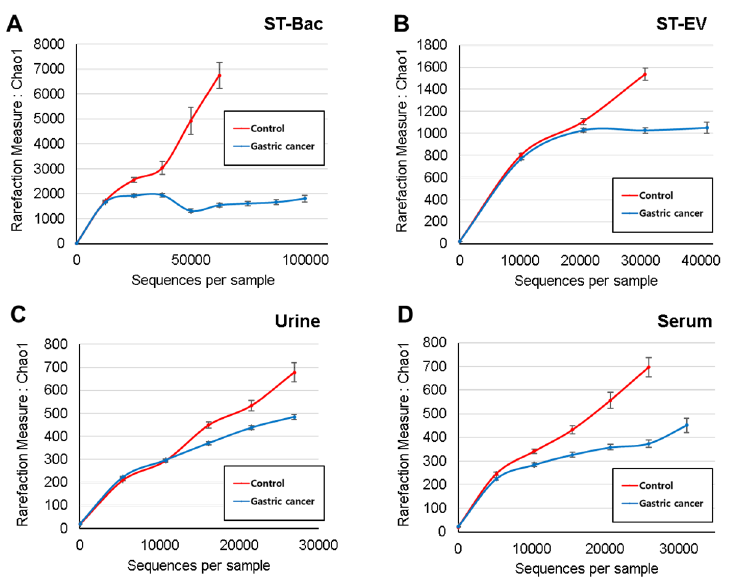
Figure 1. Comparison of alpha diversity between healthy controls and gastric cancer patients in 4 sample types. Estimated species richness (Chao1 measure) is demonstrated for the two groups ( A ) in stool bacteria (ST-Bac) isolated from stool pellet, ( B ) in stool-derived extracellular vesicle (ST-EV) isolated from stool supernatant, ( C ) in urine, and ( D ) in serum.